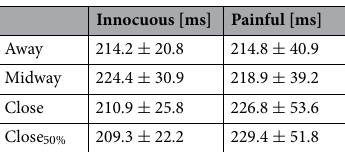
Table 2. Reaction time (cid:31) t r